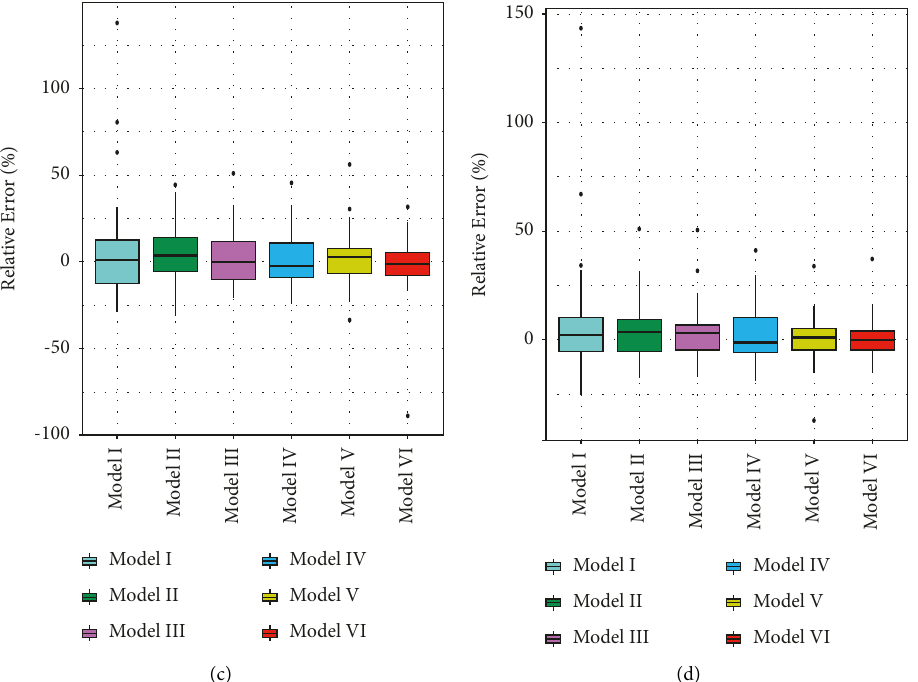
Figure 15: Relative error percentages of the developed AI models for the three tested scenarios. (a) DLNN model. (b) MARS-model. (c) ELM-model. (d)